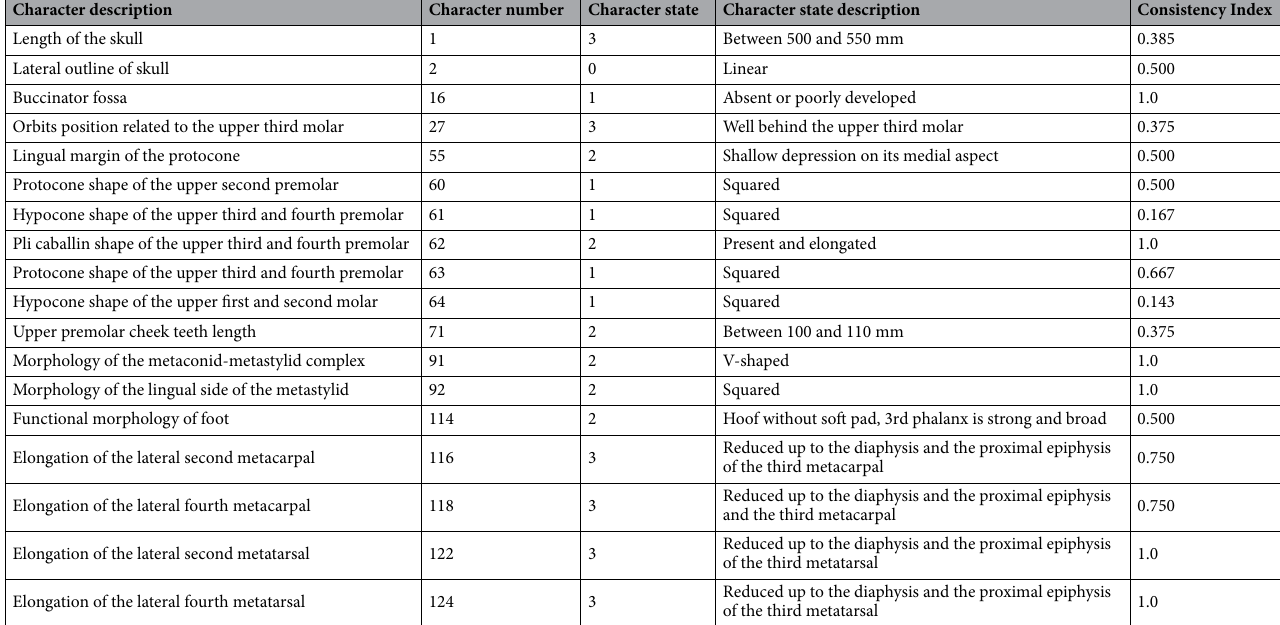
Table 1. List of unambiguous synapomorphies of the Equus clade (node 52 in Fig.